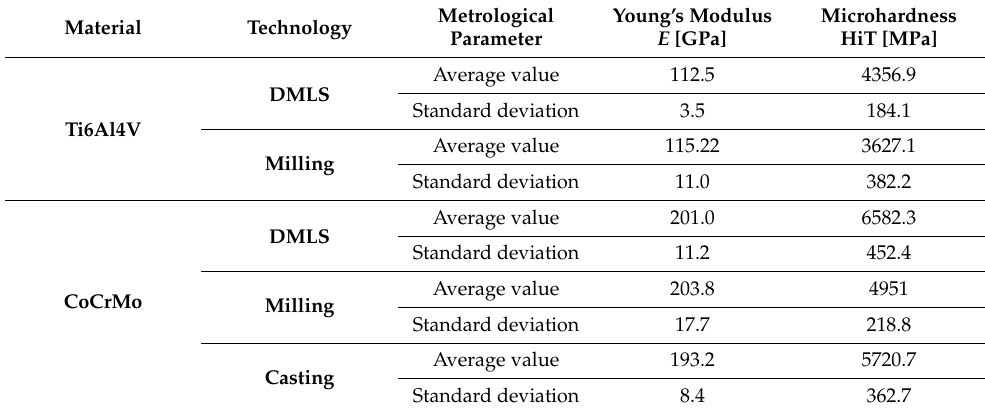
Table 3. The results of the modulus of longitudinal elasticity and microhardness determined by the nanoindentation method